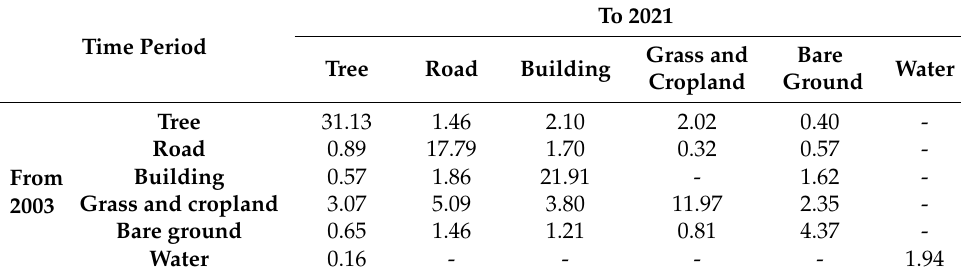
Table 2. Land cover transition matrix (unit: km 2